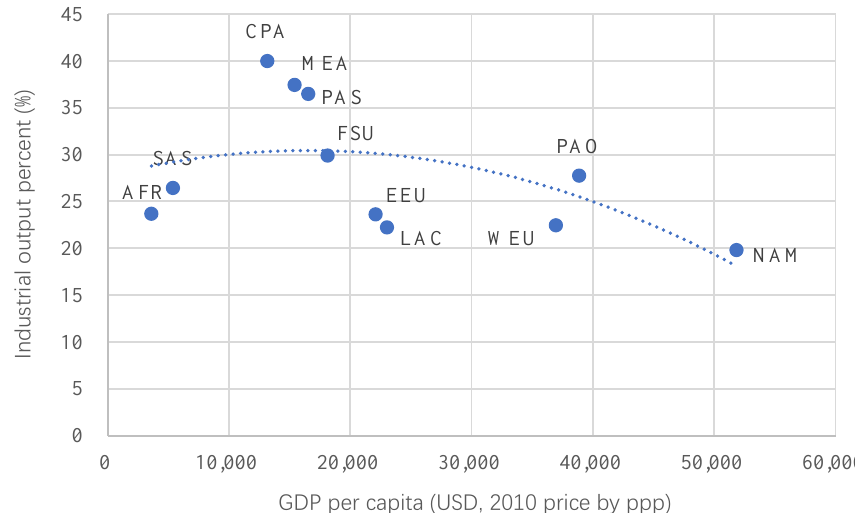
Figure 1. The status of industrialization globally and across 11 regions in 2015. Note: (1) 11 regions are defined by International Institute for Applied Systems Analysis (IIASA) [32]. (2) Data of GDP per capita and industrial output percent are retrieved from the World Bank Database [33]. (3) Dashed line is the world average; dotted line is the regression line from the 11 regions GDP per capita and industrialization data.